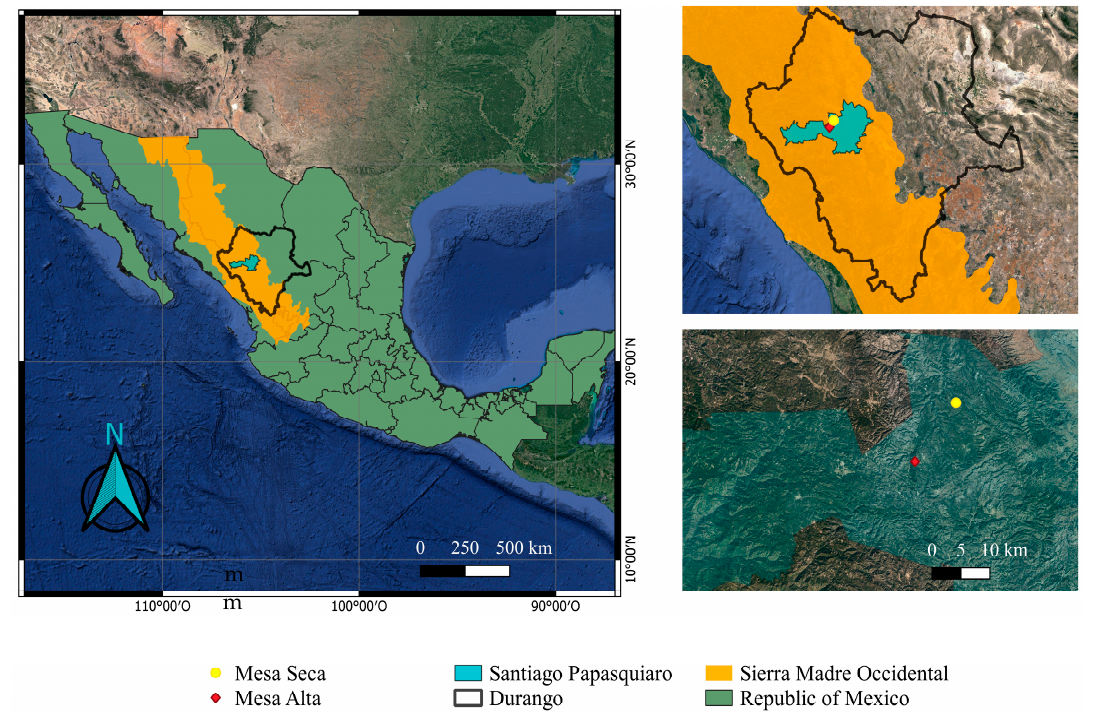
Figure 1. Location of the two study sites where the seedlings of interest were planted and are growing.